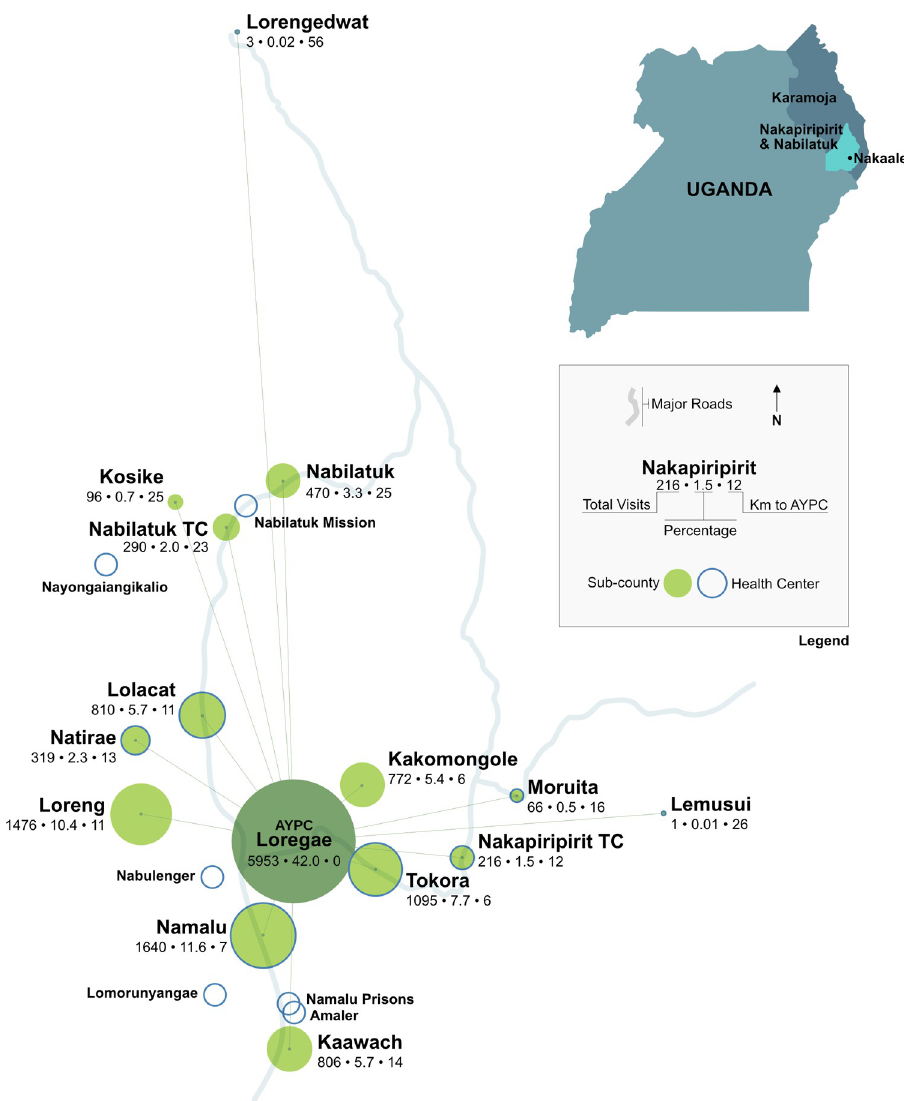
Fig 2. Total visits and kilometres from various sub-counties to AYPC in Nakaale in 2019. Created using Affinity Designer Software [31]. Sub-counties and health centres were plotted according to their visual location on a satellite base map from the U.S. Geological Survey using physical characteristics such as rivers, elevation, roads, and outlines of villages. Distances between each sub-county and AYPC, presented as the length of the lines, were measured relying on spatial distances from the U.S. Geological Survey [25]. The lines are arranged in a radial format with accurate angles representing where on the compass different locations lie in relation to AYPC. The number of clients seeking care at AYPC from sub-counties within Nakapiripirit and Nabilatuk Districts is shown by the size of the circle surrounding each sub-county name on the figure. The three numbers below the sub-counties refer to the total number of visits of clients from that location to AYPC, the percentage those visits comprise of the total observations for this paper, and the distance in kilometres that each sub-county is away from AYPC. Distances from AYPC are measured as the crow flies instead of the path someone might take along actual roads, which are shown on the infographic to spatially orient each sub-county. The thumbnail map of Uganda uses a base map from the Ugandan Electoral Commission’s website [25]. The GPS co-ordinates of AYPC are 1˚51’25.8”N